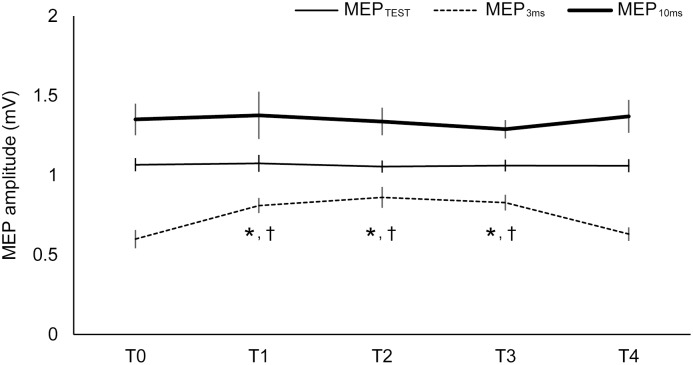
Changes in MEP amplitude induced by adjusted test stimulus (TS) in whole-body WF.TS intensity was adjusted to elicit an unconditioned test MEP in the relaxed right FDI of approximately 1 mV peak-to-peak amplitude in each assessment. Asterisks (*) indicate significant differences (p<0.05) compared with T0. Daggers (†) indicate significant differences (p<0.05) compared with T4.